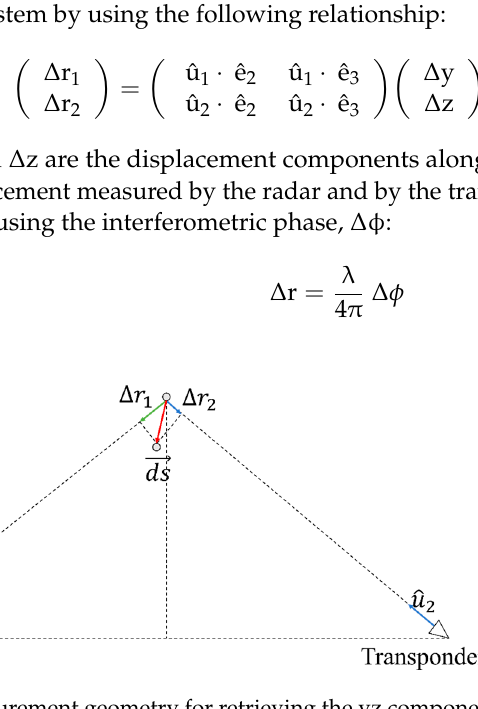
Figure 4. Measurement geometry for retrieving the yz components of displacement (side view).